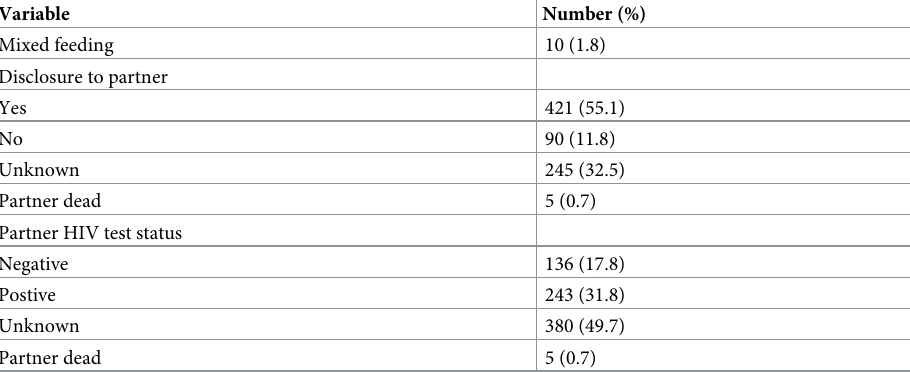
PLOS ONE | https://doi.org/10.1371/journal.pone.0198438 June 21,